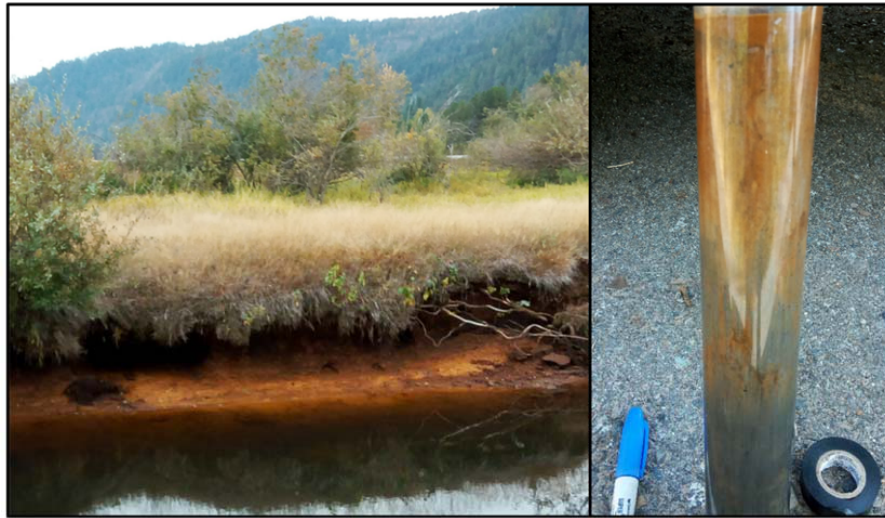
Figure 6. Images of metal-rich sediments at/from Thompson Lake in the lower basin’s lateral system of the Coeur d’Alene River near Harrison. The left image is seepage of metal-rich porewater from the bank sediments following the decrease of river/lake levels during the summer season. The right image is a shallow core taken from the lake’s shoreline that shows oxidized metals in the upper portion of the sediments.